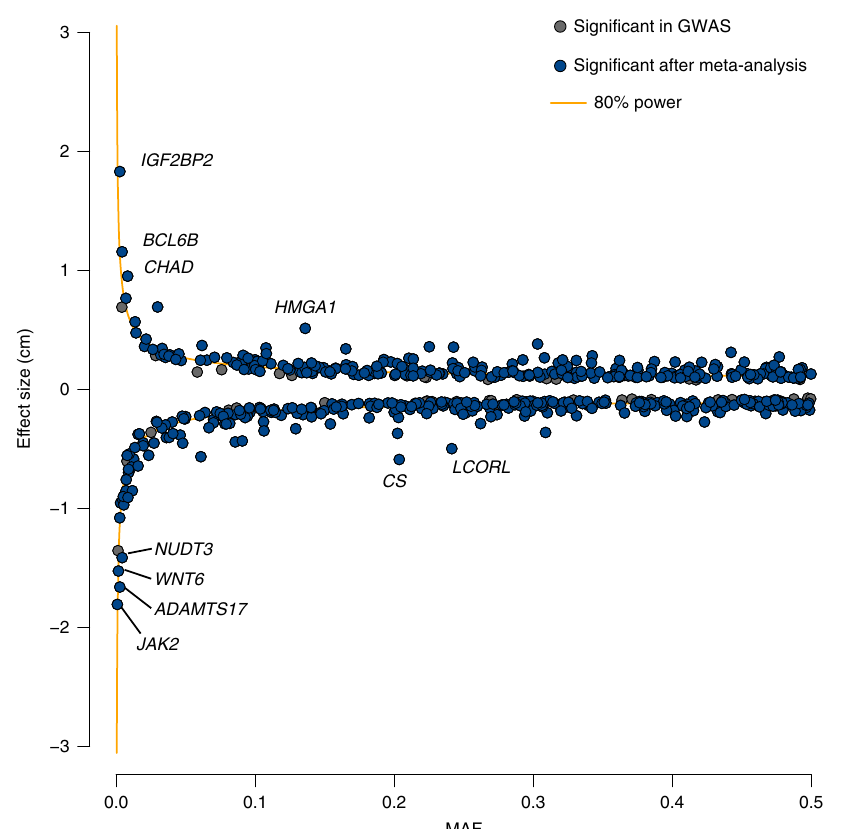
Fig. 2 Scatter plot of MAF and effect size. We plotted the allele frequency ( x- axis) and effect size ( y -axis) of the minor alleles of the 609 variants that reached genome-wide signi fi cance in the discovery GWAS. Variants that remained genome-wide signi fi cant after the meta-analysis are indicated in blue. The orange line denotes 80% power to achieve genome-wide signi fi cance. To convert the standardized effect size to a centimeter scale, we regarded 1 standard error as 5.63 cm, which was calculated in the population-based cohorts (replication